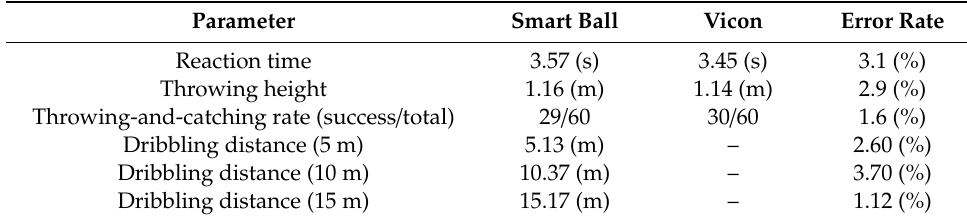
Table 5. Validation of the smart ball in the three tests. The results showed that the ball had stable error rates in measuring all